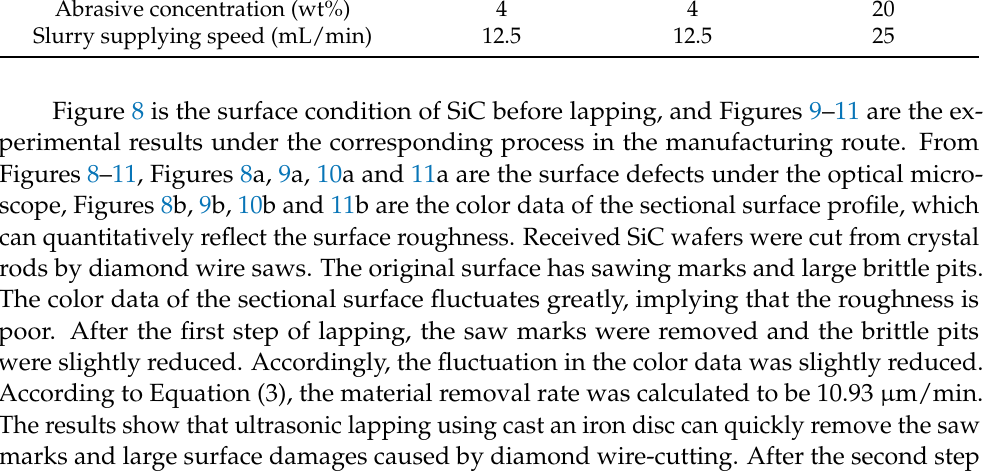
Figure 7. Optical images after lapping using aluminum disc: ( a ) common lapping; ( b ) ultrasonic-assisted lapping.